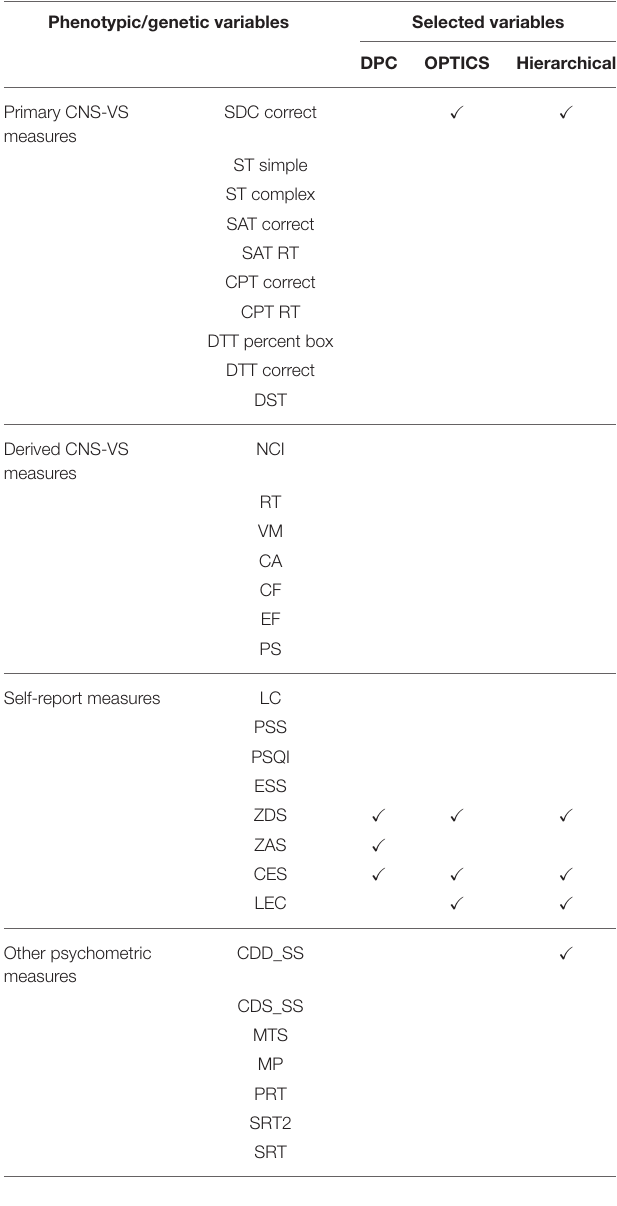
TABLE 4 | Phenotypic variables selected by GA with different clustering methods (PTSD/PCS). Phenotypic/genetic